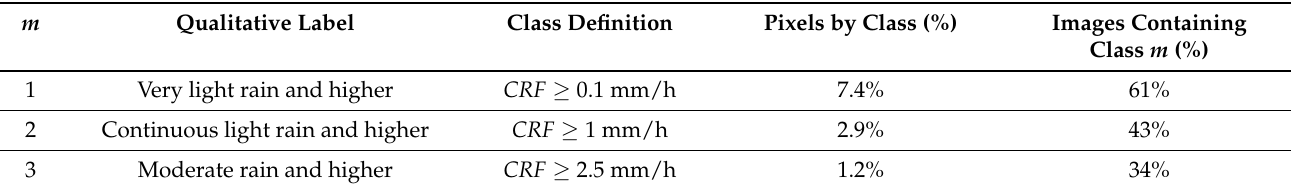
Table 1. Summary of classes definition and